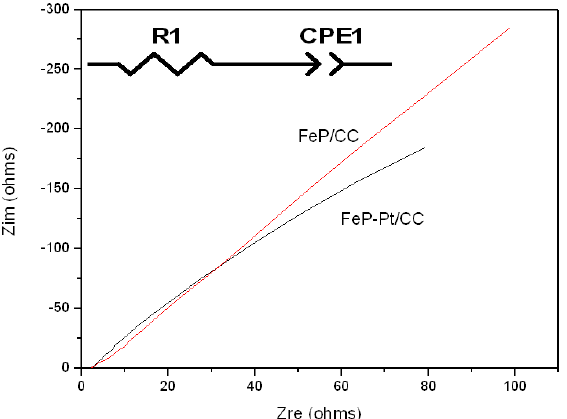
Figure 7. Nyquist plots of FeP ‐ Pt/CC and FeP /CC at − 0.2 V in 1M KOH. The inset is the equiva ‐ lent electrical circuit. Table 2. Element values in the equivalent circuit of AC impedance spectrum in 1M KOH .